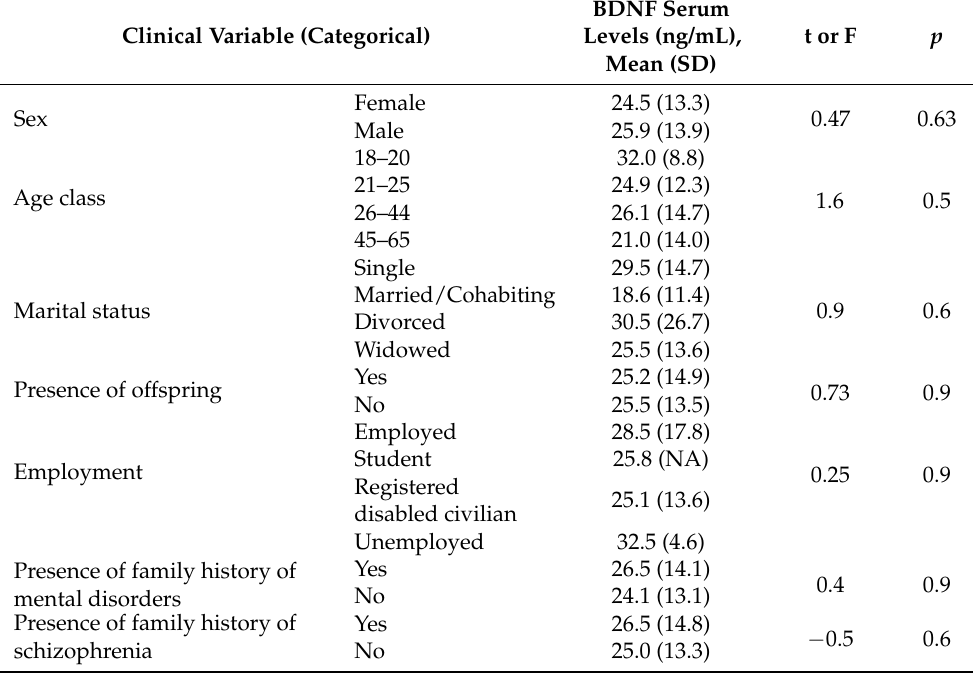
Table 4. Association of BDNF serum levels with categorical demographic and clinical variables in 105 patients with schizophrenia and schizoaffective